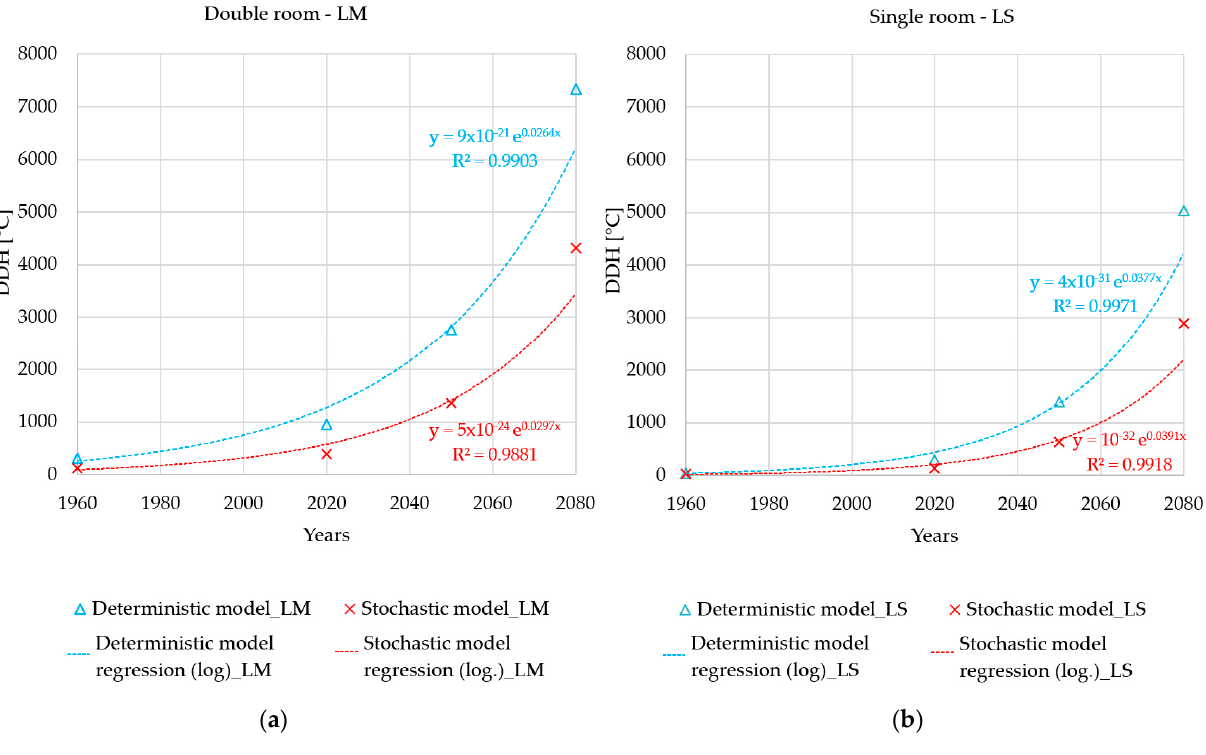
Figure 10. Trend of DDH by the adoption of the rule-based and stochastic models for the LM room ( a ) and LS room ( b ).